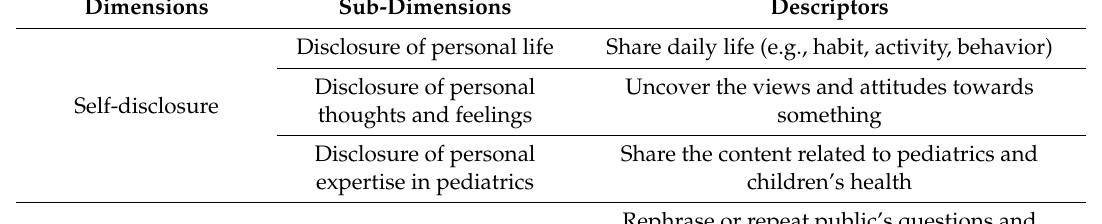
Table 2. The major dimensions, sub-dimensions and descriptors of the code